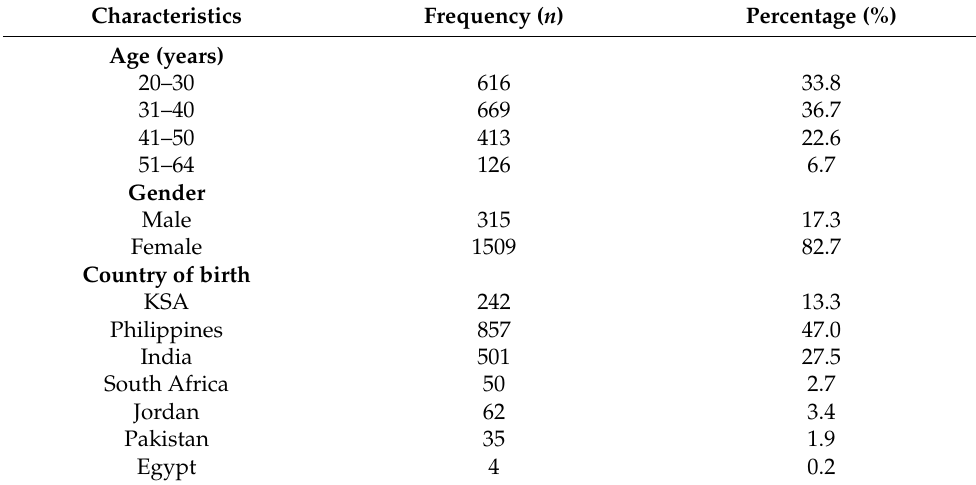
Table 1. Demographics of the respondents ( n =